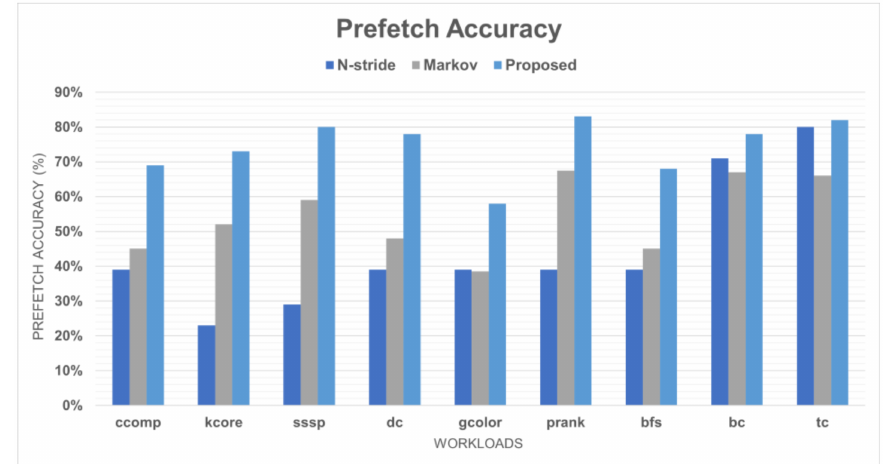
Figure 17. Prefetch accuracy of basic